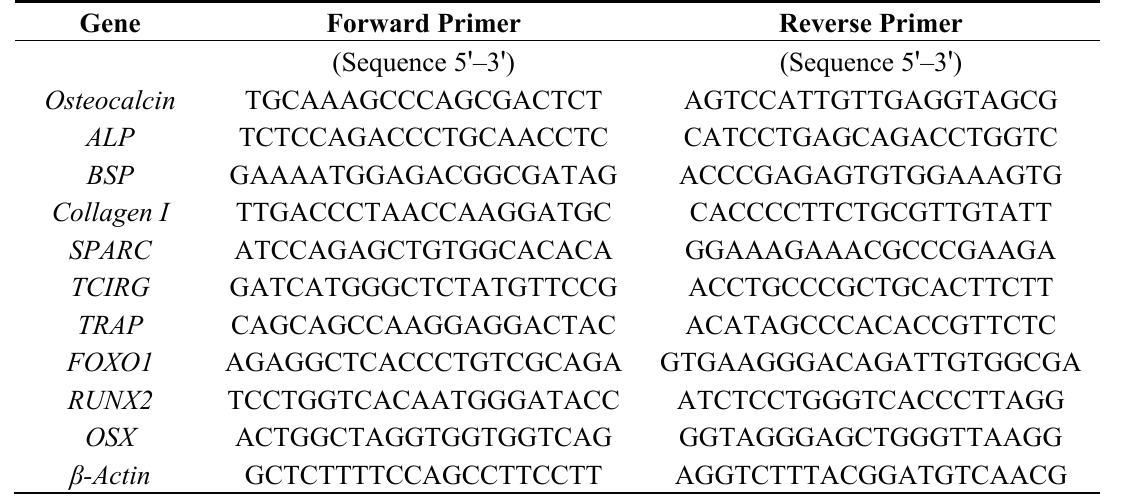
Table3. Primer sequences used for real-time